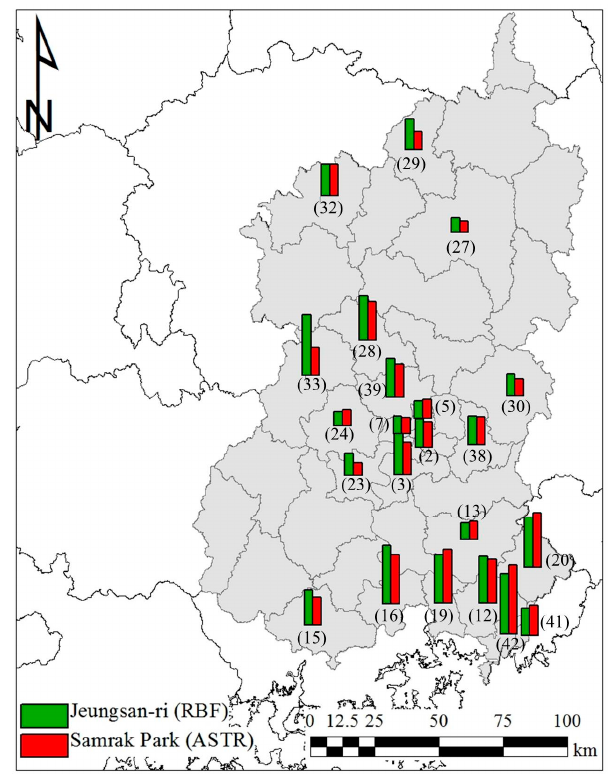
Figure 9. Cities’potential risk of 100-year return period.